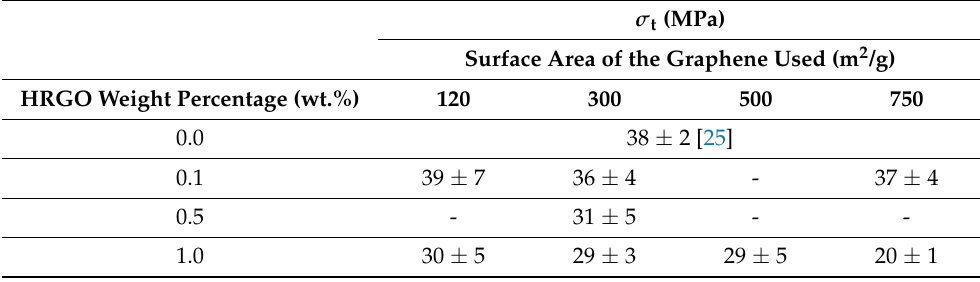
Table 8. Modulus of elasticity, E , of the material versus the percentage and surface area of the added HRGO. Each result shows the mean value and root mean square error. E (GPa) Surface Area of the Graphene Used (m 2 /g) HRGO Weight Percentage (wt.%)